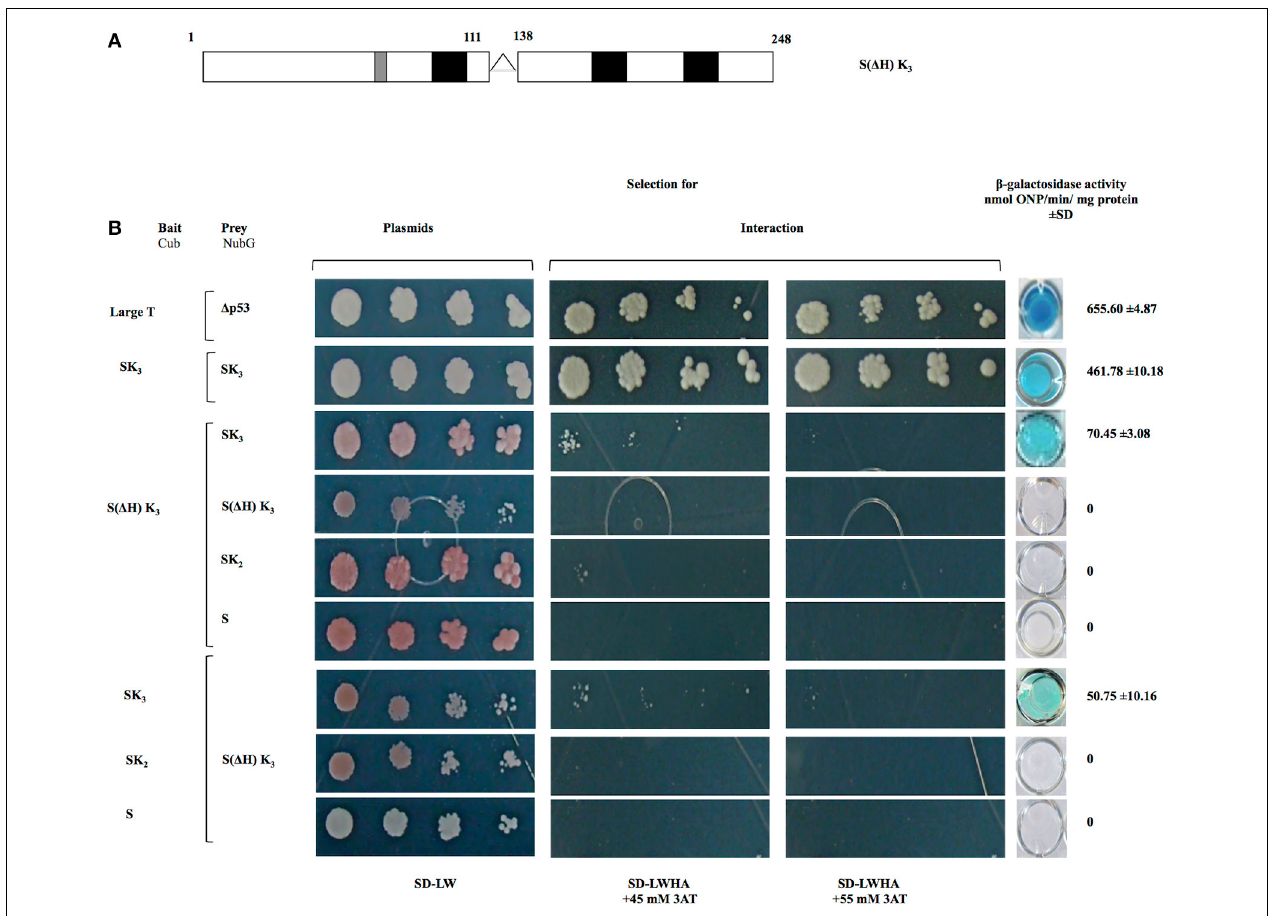
S( (cid:2) H) K 3 , SK2, and S] prey vectors, interaction analysis of the swapped versions in the respective bait and prey vectors. Yeast strains was plated to an OD600 of 0.8, and at serial 10-fold dilutions on semi-selective (SD-LW) and on selective (SD-LWHA) media supplemented with 3-AT (45 and 55mM). Quantitative β -Galactosidase activity was assayed by hydrolysis of the o -nitrophenyl-b-galactoside (ONPG), as expressed in nmol ONP/min permg of protein. Data represent the mean ± SD , ( n = 3).